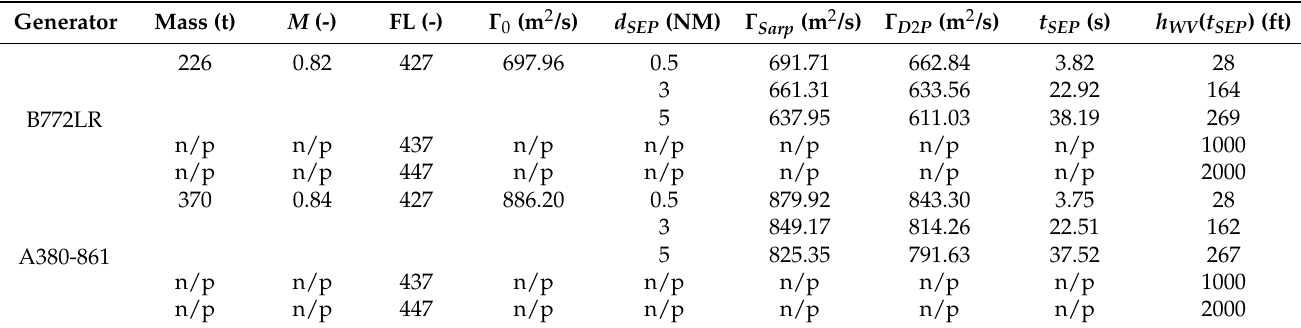
Table A4. Maximum circulations of wake vortex encountered by aircraft behind several generator aircraft in realistic scenarios at the ceiling of B772LR, and flight conditions of the generator. Generator